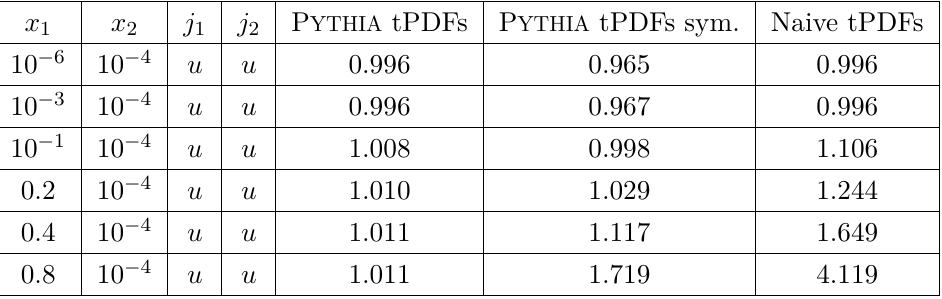
Table 11 . Test of the momentum sum rule for the tPDFs. In the ideal situation when the momentum sum rule is perfectly satisfied the number in each cell should be equal to unity.